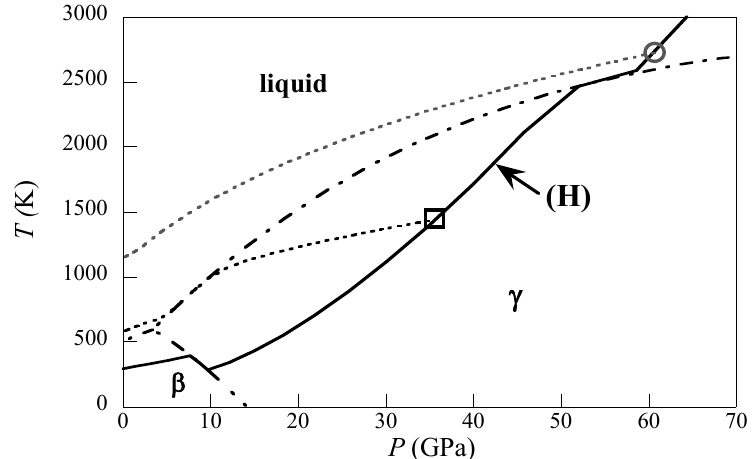
Figure 1. Illustration of shock-induced melting in tin. The Hugoniot curve (H) is plotted in the solid line, in a pressure-temperature (P-T) diagram showing equilibrium phase boundaries (mixed lines). Two examples illustrate respectively melting under compression (circle) or upon release (square). Dotted lines are the isentropic release paths from both shocked